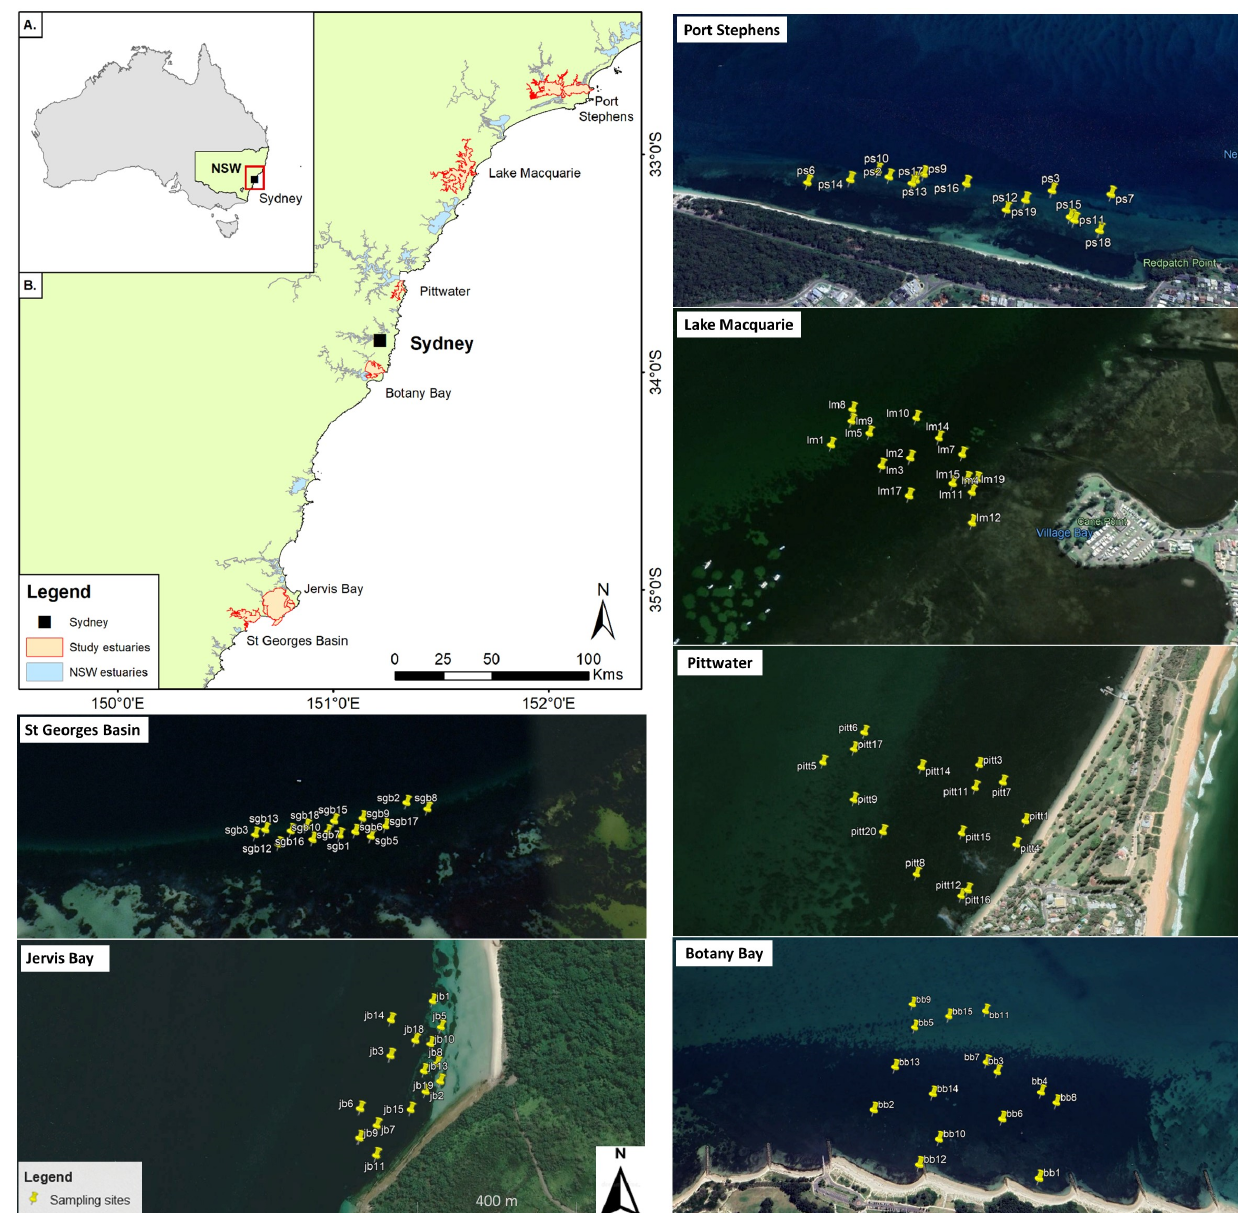
Figure 1. The coastline sampled along the east coast of Australia is highlighted by the red box ( A ). Map of the six estuaries sampled in New South Wales ( B ). Map credits: Jordan Gacutan. Aerial imagery of the six meadows sampled for this study with sampling sites in yellow: Port Stephens, Lake Macquarie, Pittwater, Botany Bay, Jervis Bay and St Georges Basin. Imagery collected from Google Earth (2021). Under the NSW Government legislation P. australis is classified as non-endangered in Port Stephens, Jervis Bay, St Georges Basin, while it is classified as endangered in Lake Macquarie, Pittwater and Botany Bay. Port Stephens, Lake Macquarie, Pittwater and Botany Bay are also listed as endangered ecological communities under the Commonwealth legislation.